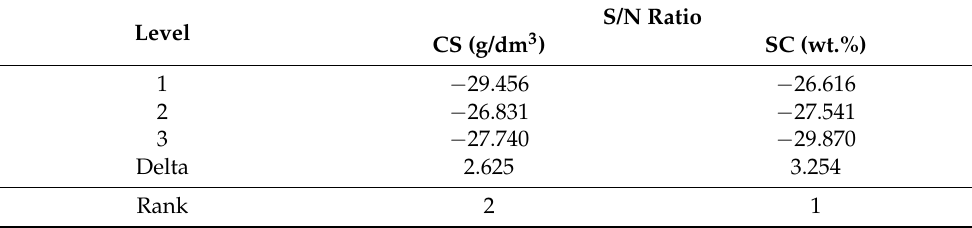
Table 4. S/N ratios of APDP by parameter level (SB).